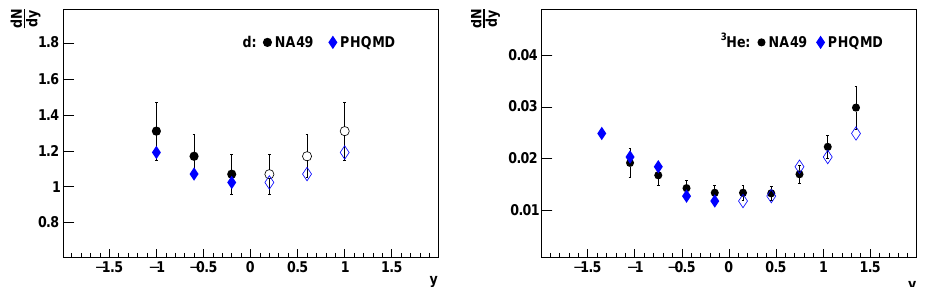
Figure 2. Rapidity spectra of deuterons and 3 He in the central Pb+Pb collisions. Experimental data (black circles) are taken from NA49 Collaboration [9].